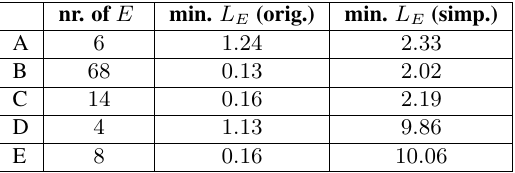
Table 1. Comparison of original and simplified building geometries: number of edges with length < 2 m (original), minimal edge length (original) and minimal edge length (simplified).